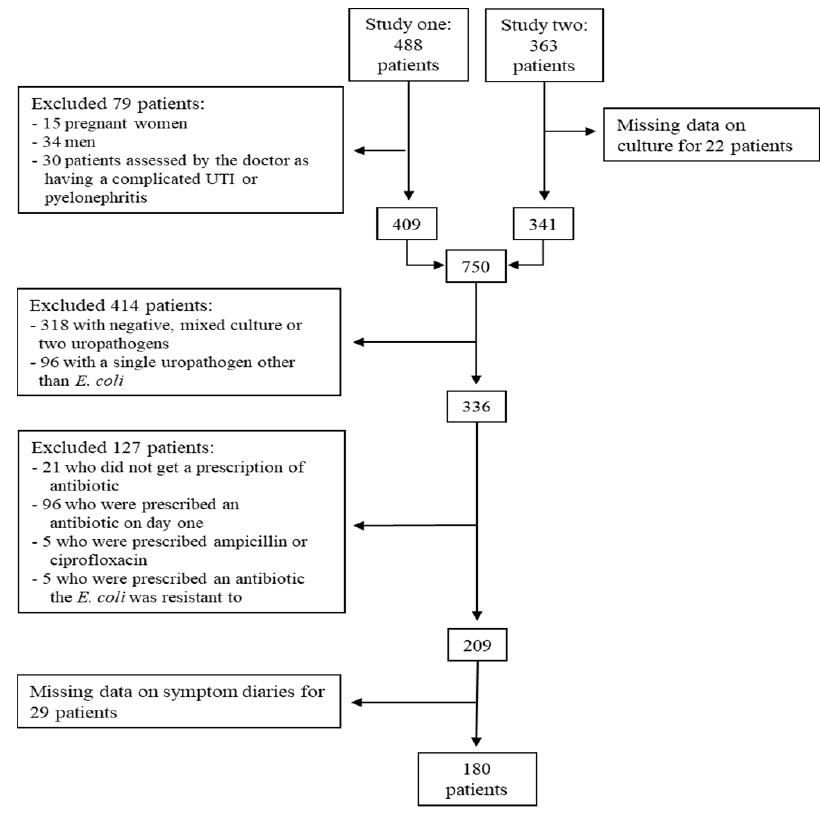
Figure 1. Included patients.